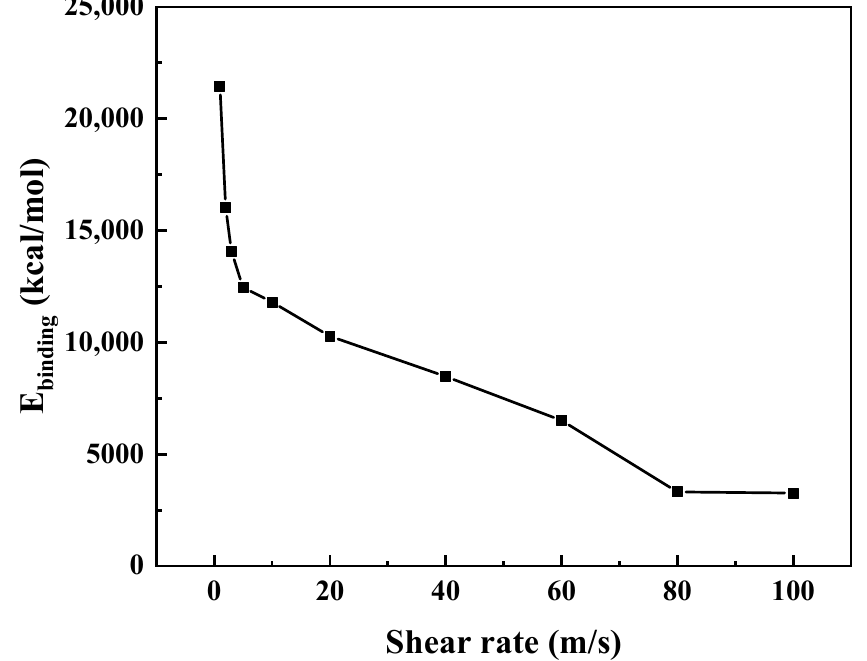
Figure 13. Binding energies (E binding ) of warm mix asphalt lubricating film between calcite (104) surfaces.